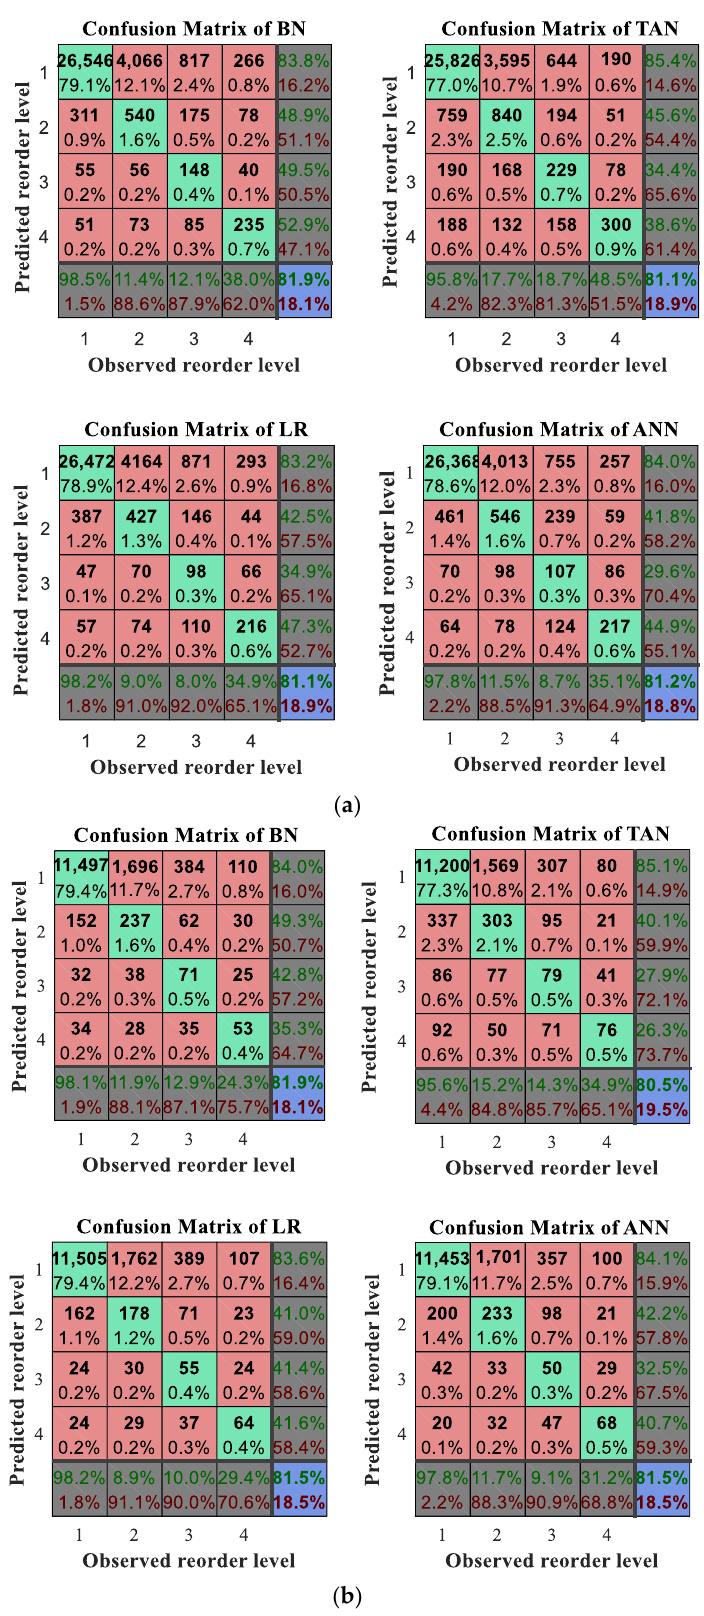
Figure 9. Confusion matrix of different approaches. ( a ) Confusion matrix of different methods for training samples. ( b ) Confusion matrix of different methods for test samples.